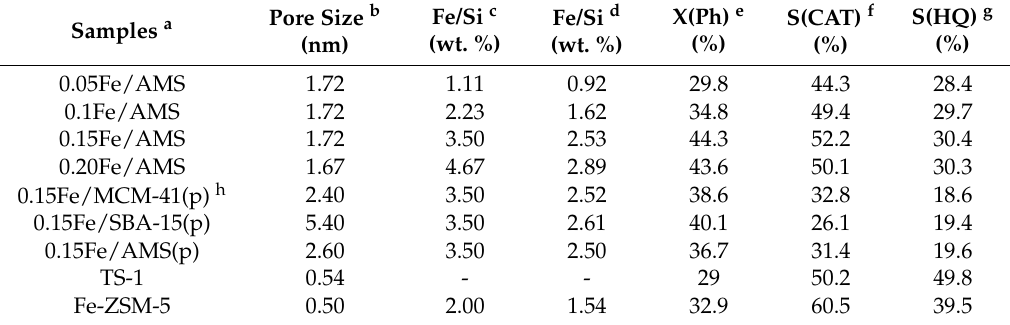
Table 5. The catalytic activities of the samples with different pore size for phenol